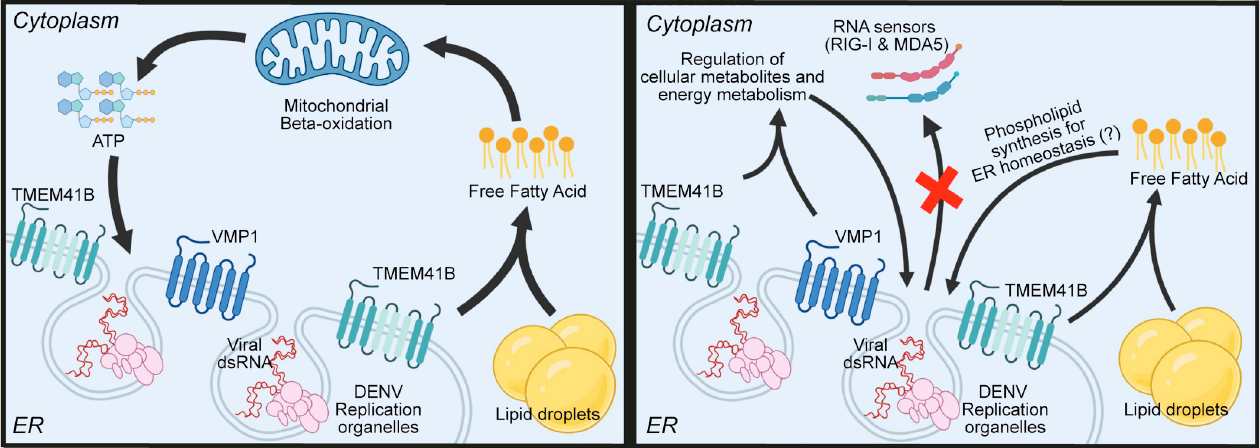
Fig 6. The schematic model for multiple roles of TMEM41B and VMP1 in DENV infection. TMEM41B and VMP1 modulate ER homeostasis, lipid mobilization, mitochondrial beta-oxidation, and global metabolomic regulations to facilitate productive DENV infection. This figure was created with